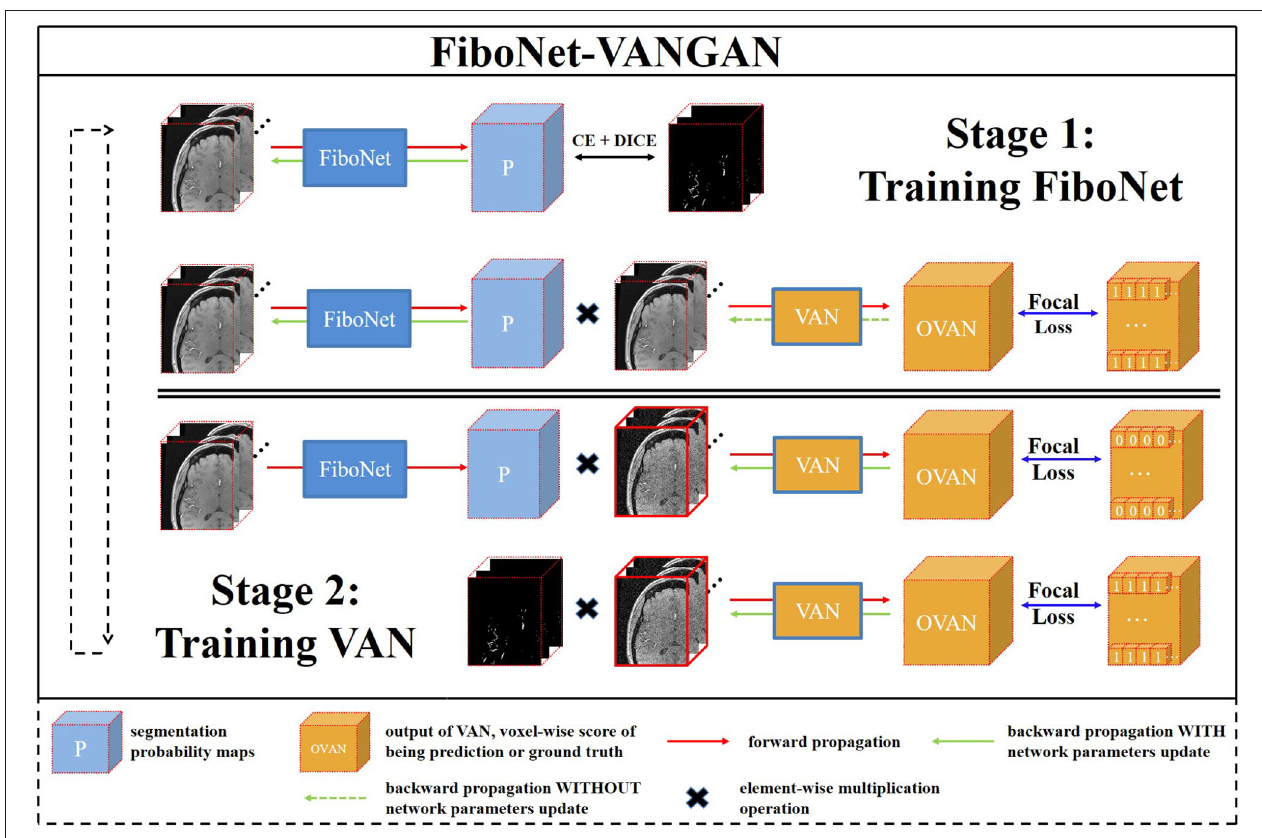
FIGURE 3 | An overview of our proposed voxel-wise focal generative adversarial network (GAN) for cerebrovascular segmentation. Two stages are included in one training iteration. FiboNet is trained in stage one and voxel-wise adversarial network (VAN) is trained in the stage two.